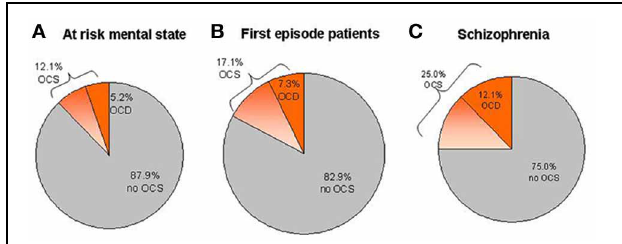
FIGURE 1 | Prevalence estimations of OCS and OCD within different samples of patients. (A) Mean prevalence rates in ARMS studies. (B) Mean prevalence rates in first-episode psychotic patients. (C) Mean prevalence rates in patients suffering from chronic